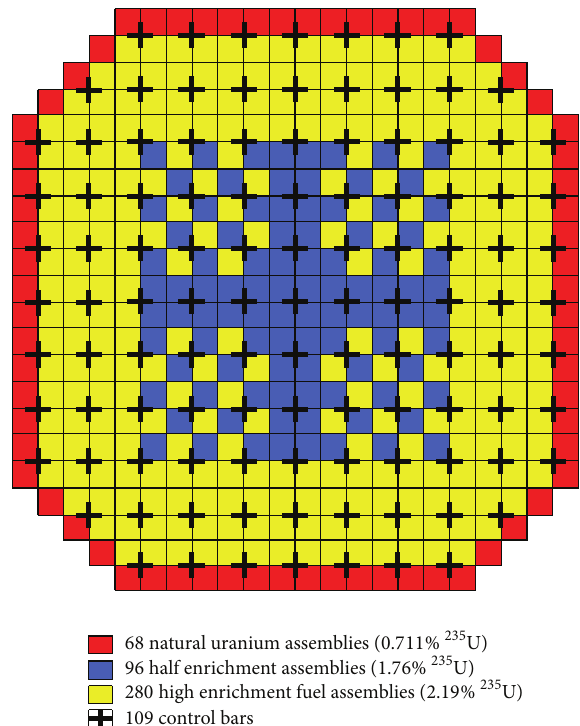
Figure 1: Schematic of a cross section of one of the LVNPP reactor cores [17]. The “red” assemblies (0.711%) are located on the perimeter of the reactor core, while the “blue” assemblies (1.76%) are arranged in the central area. There are 109 control bars represented as crosses in the figure.